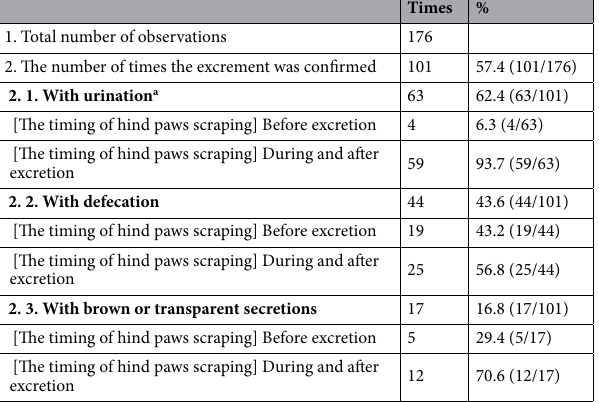
Table 3. Excrement production during scraping and the timing of hind paws scraping. a Indicates significant difference between “before excretion” and “during and after excretion” ( p < 0.05: binomial